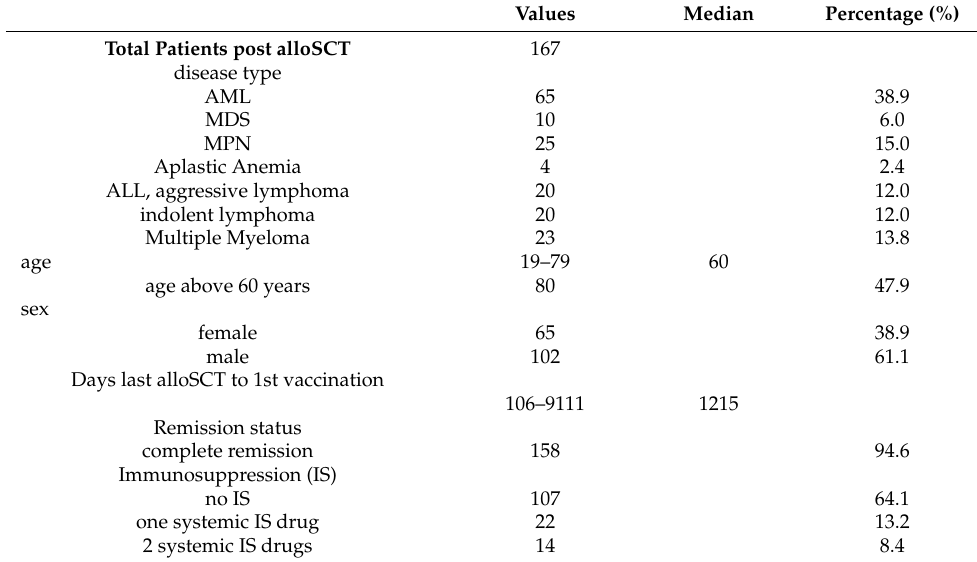
Table A1. Patient